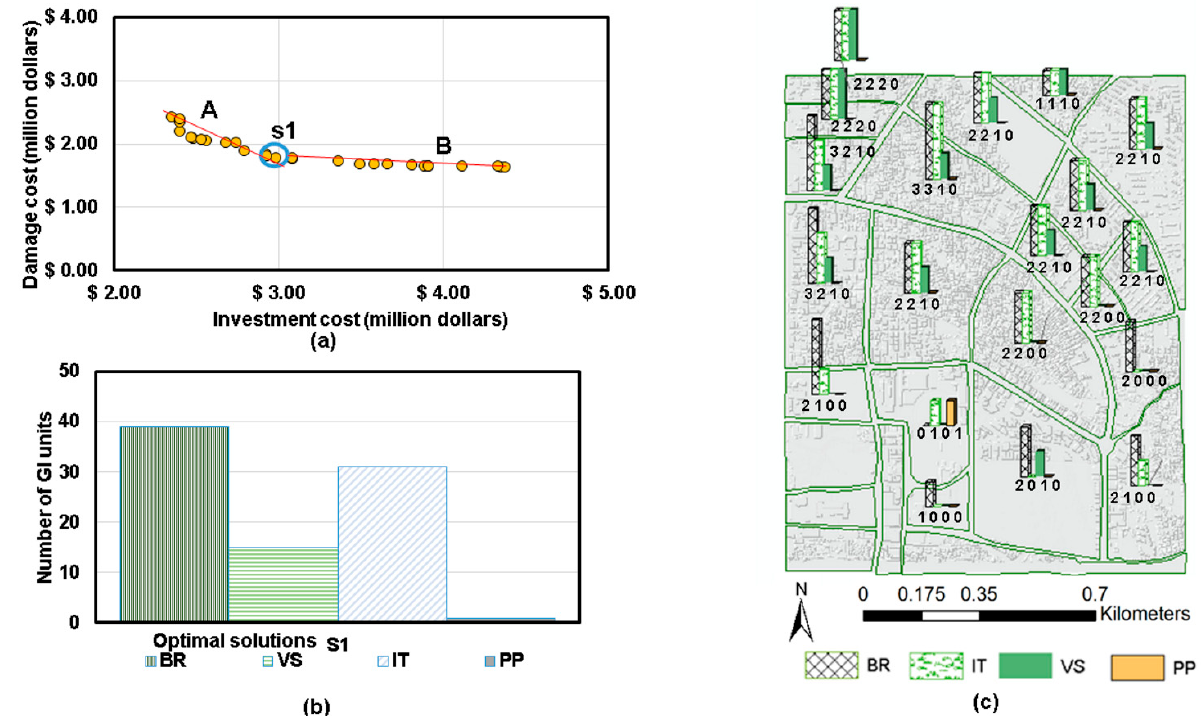
Figure 4. ( a ) The non-dominated optimal solutions implementing green infrastructure. ( b ) Optimal number of GI practices associated with solution s1. ( c ) Optimal number of green infrastructures allocated in the catchment (solution s1).